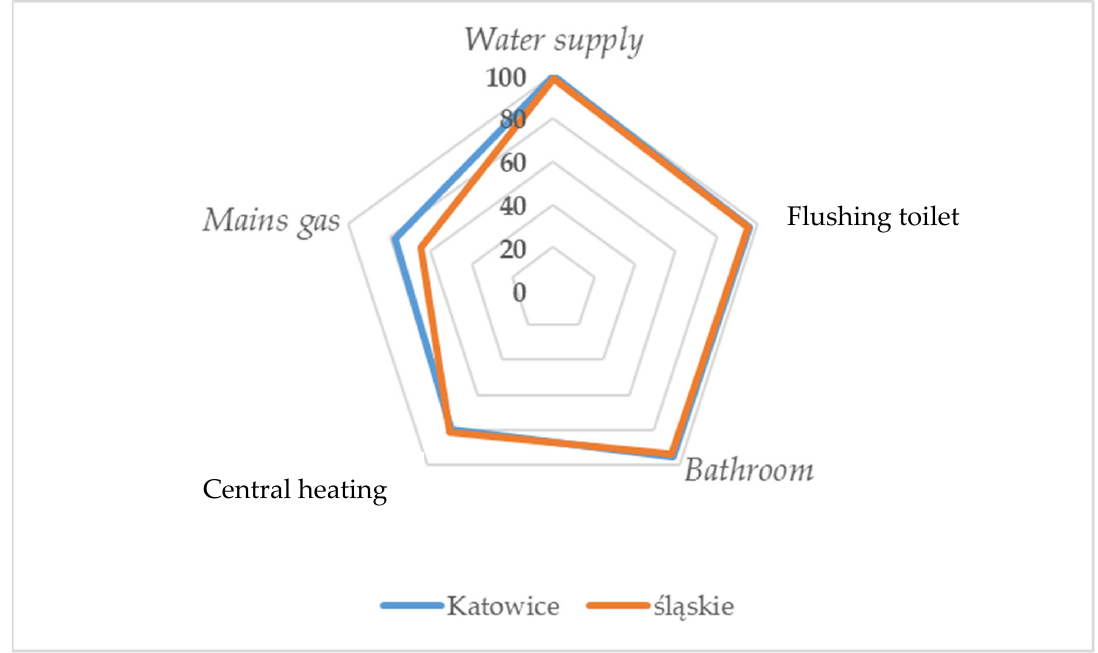
Figure 7. Indicators of housing infrastructure quality in Katowice and the Silesian Province. The differences in the quality of housing infrastructure between Gda´nsk and Pomera- nian Province are not that significant (Figure 4). Virtually all units at both levels of